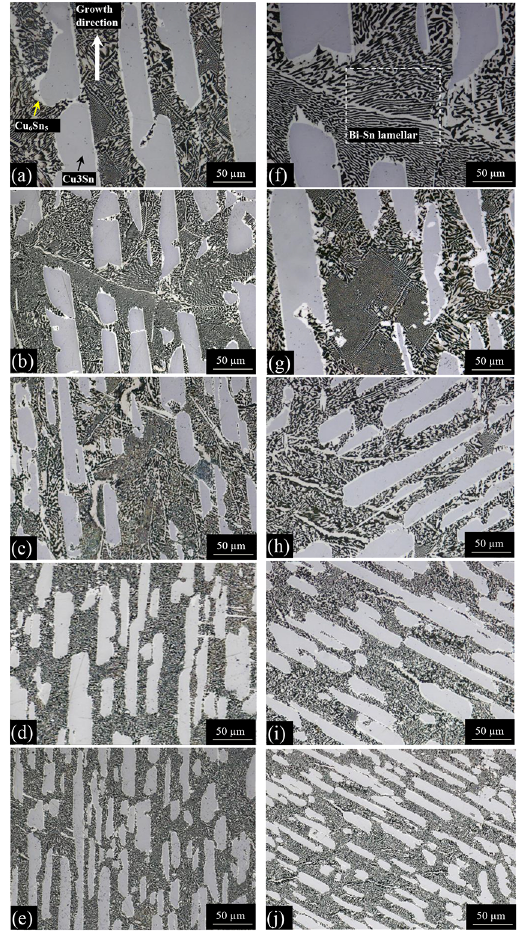
Figure 4. Optical images of the directionally solidified Sn-36Bi- 22Cu eutectic alloy at a constant temperature gradient (G=4.2 K/ mm) (a-e) longitudinal section (V=8.3-166.0 µm/s), (f-j) transverse section (V=8.3-166.0 µm/s)